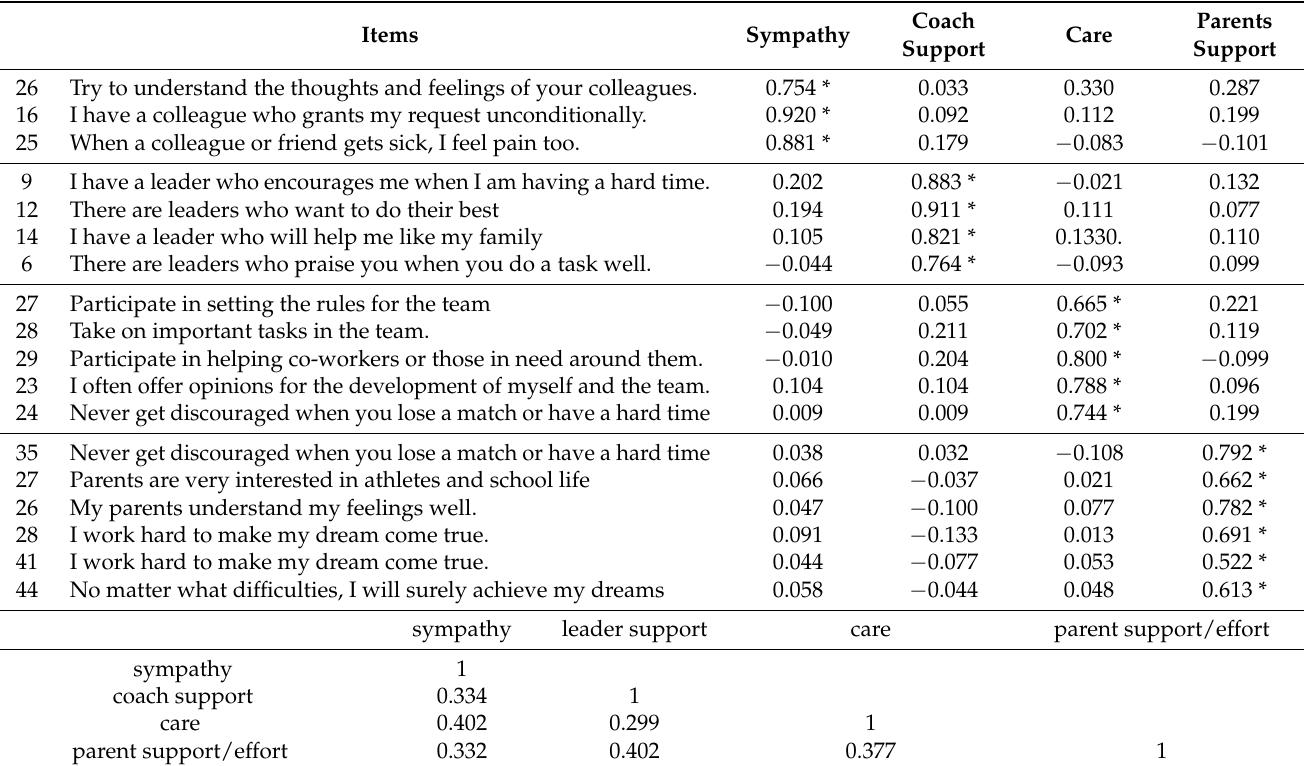
Table 9. Results of ESEM